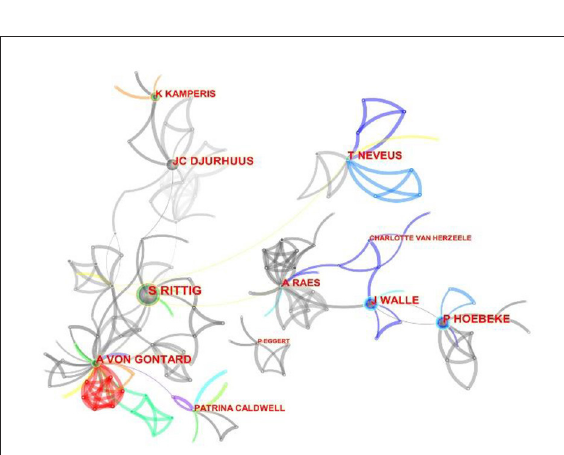
FIGURE5 Network of authors’ cooperation on NE research. Each circle represents an author. The size of the circle is positively related to the number of articles published by the author, and the thickness of the line is positively correlated with the frequency of cooperation.